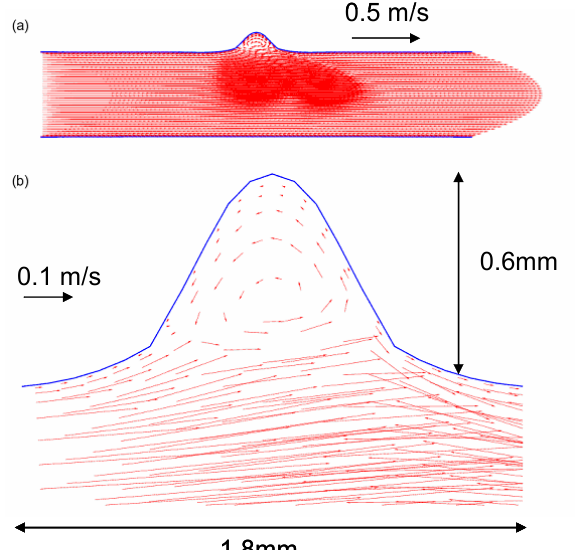
Fig. 2 Velocity distribution of the straight artery model. (a) whole velocity field; (b) velocity field near the aneurysmal